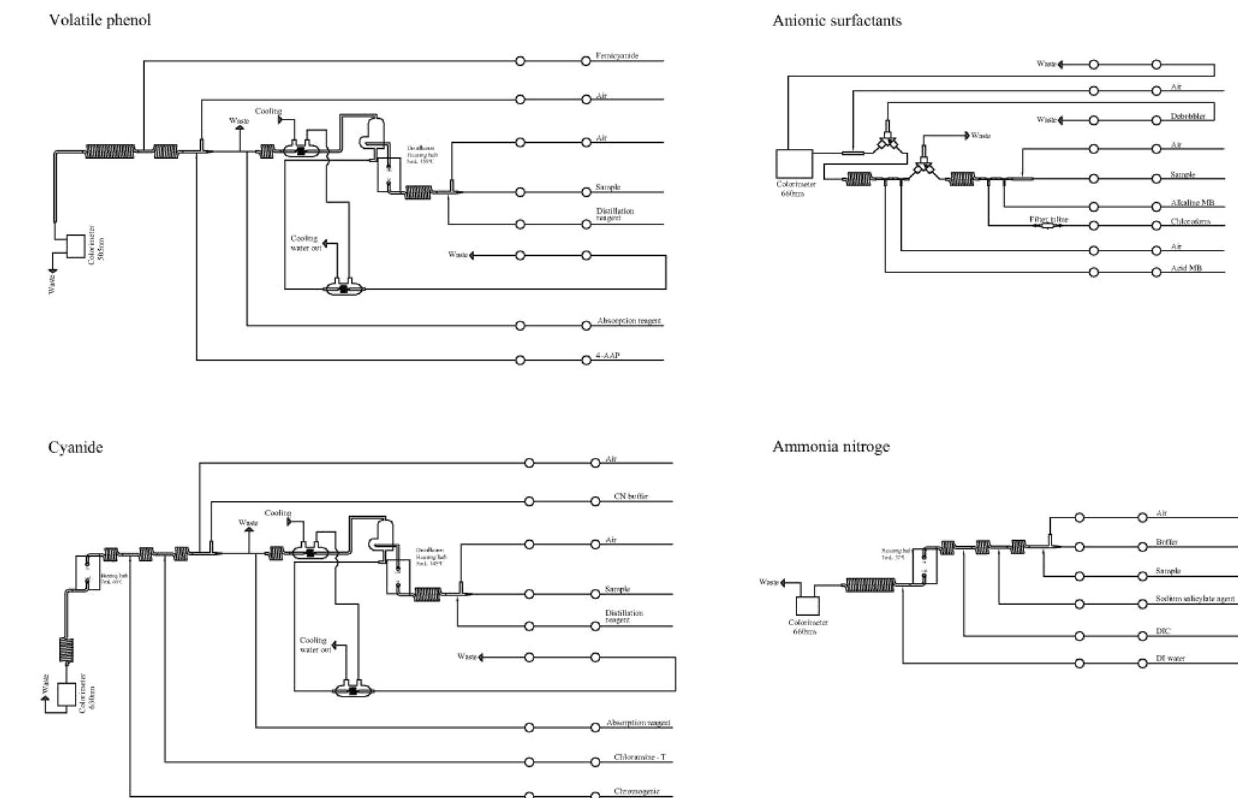
Figure 1. Schematic diagram for determination of volatile phenol, cyanide, anionic surfactant and ammonia nitrogen by continuous flow